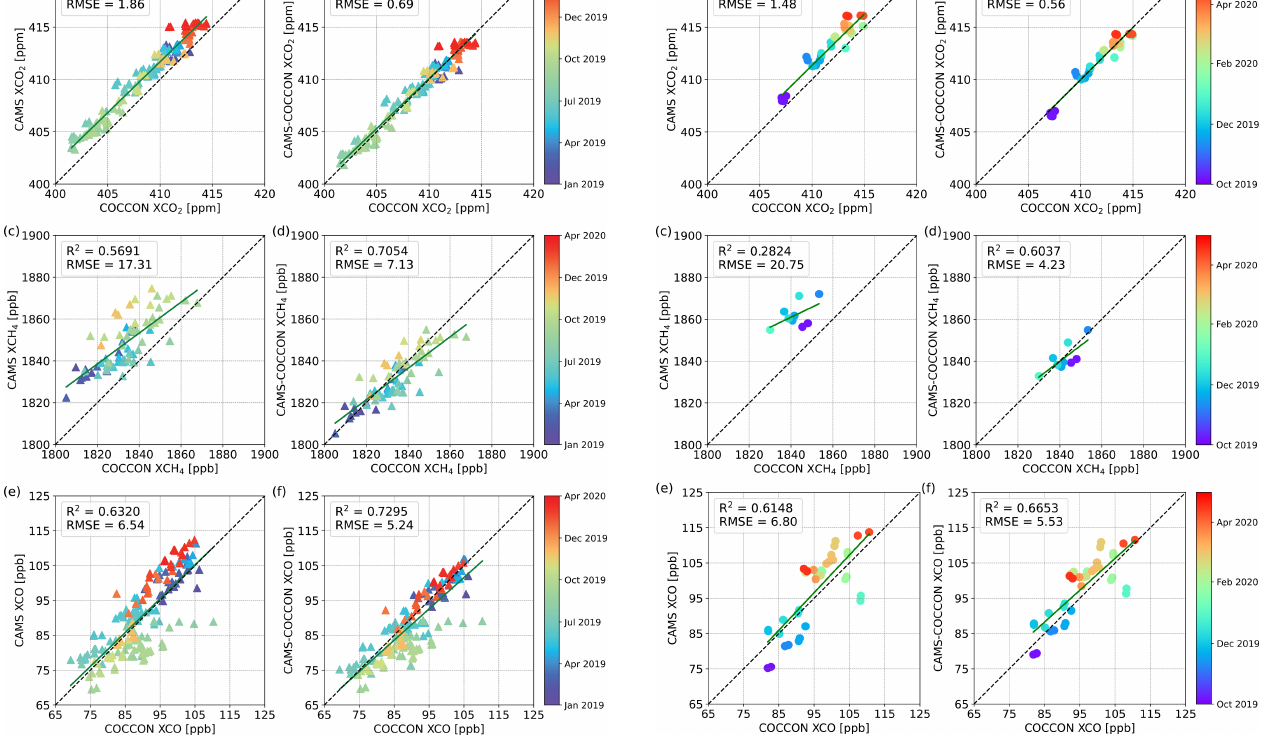
Figure A12. Correlation plots of CAMS (a, c, e) and CAMS- COCCON (b, d, f) with respect to COCCON for XCO 2 (a, b) , XCH 4 (c, d) and XCO (e, f) at Peterhof.